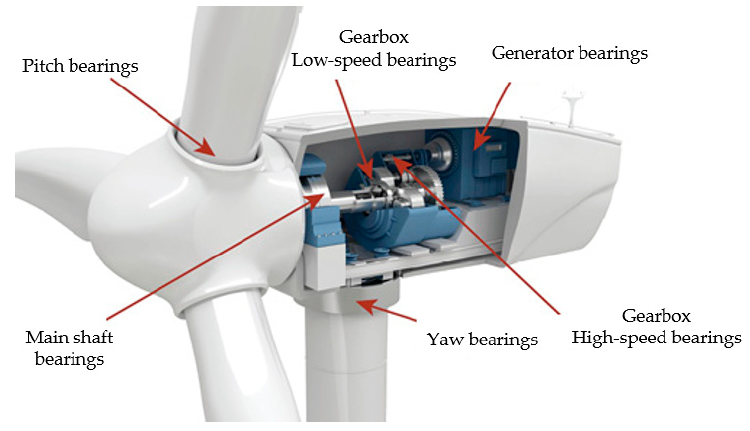
Figure 3. Bearings mounting position [27].